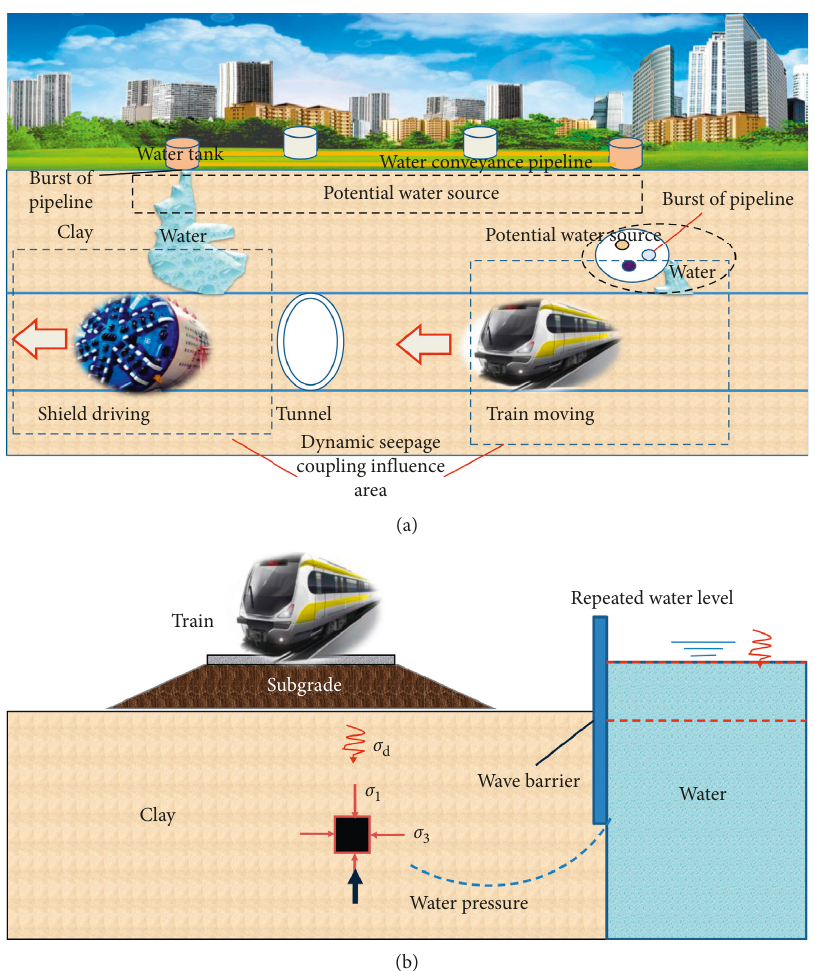
Figure 1: Engineering for coupled dynamic and seepage fields: (a) tunnel engineering; (b) subgrade